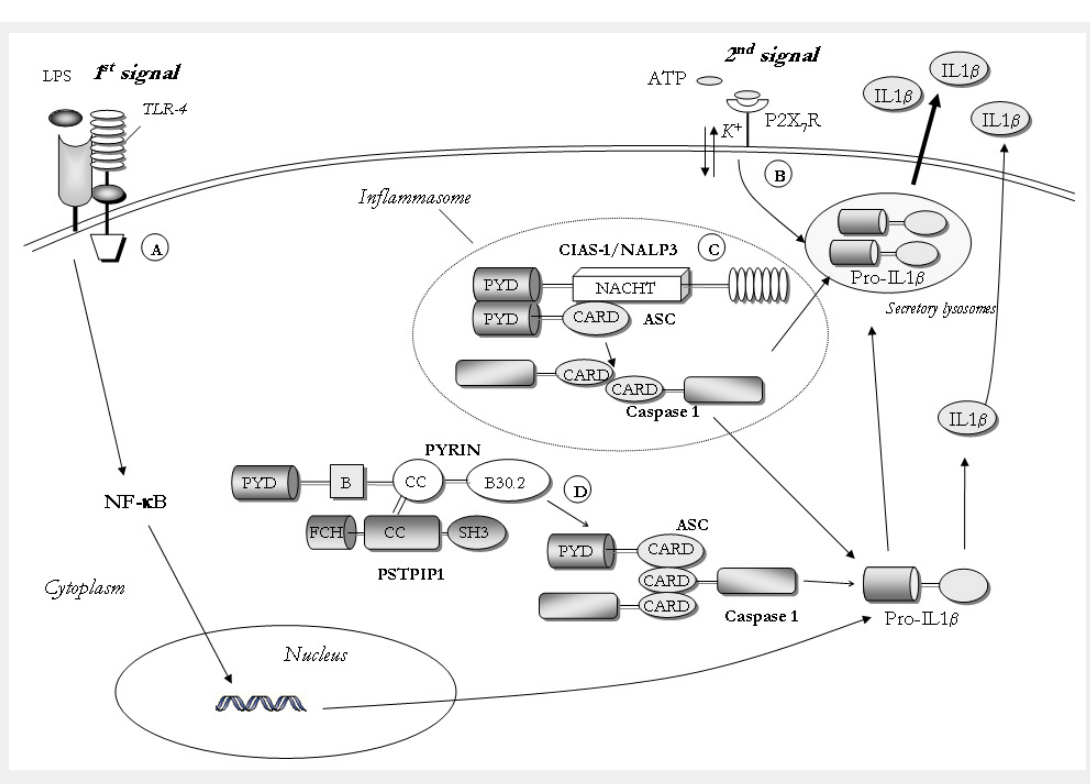
Figure 1 Role of NOD2/CARD15 in the activation of NF-κB and caspase